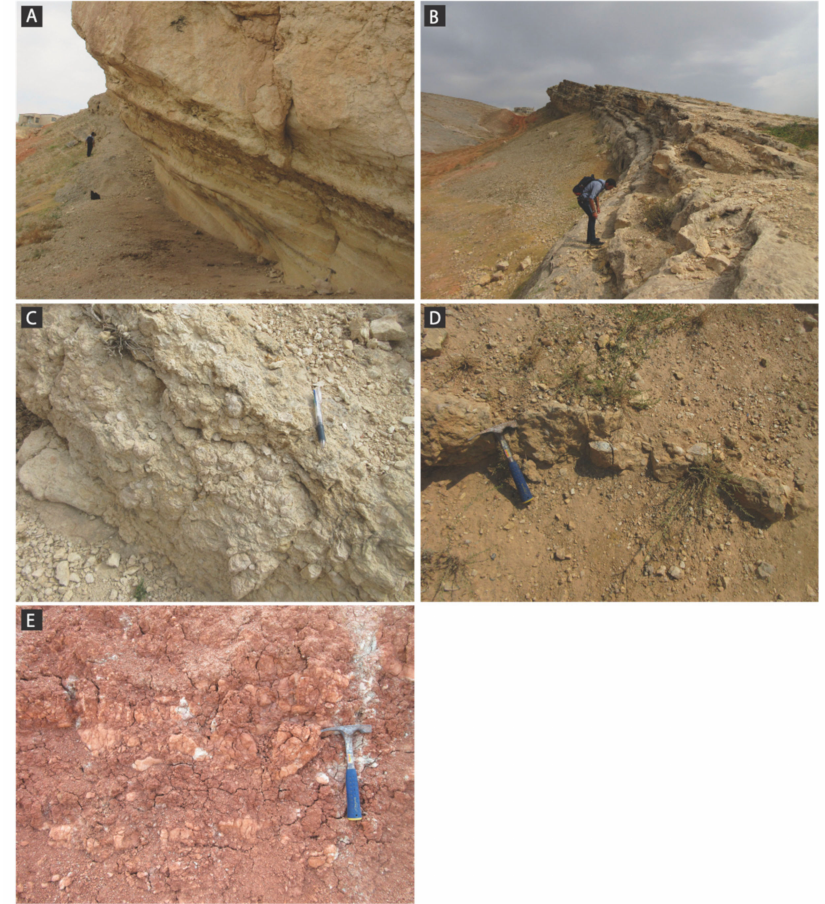
Figure 4. Field view of the sedimentary rocks at the Karabulak section of the northern Fergana Basin. ( A ) Transition of parallel sandstone to burrow-containing sandstone. The density of the burrows increased in the upward direction. The height of an average-sized man is shown for scale. ( B ) Bedded shell beds, which overlie the burrow-containing sandstone. ( C ) Close-up of the shell beds. ( D ) A shell bed in the lower sequence. ( E ) Caliche in the red beds of the lower